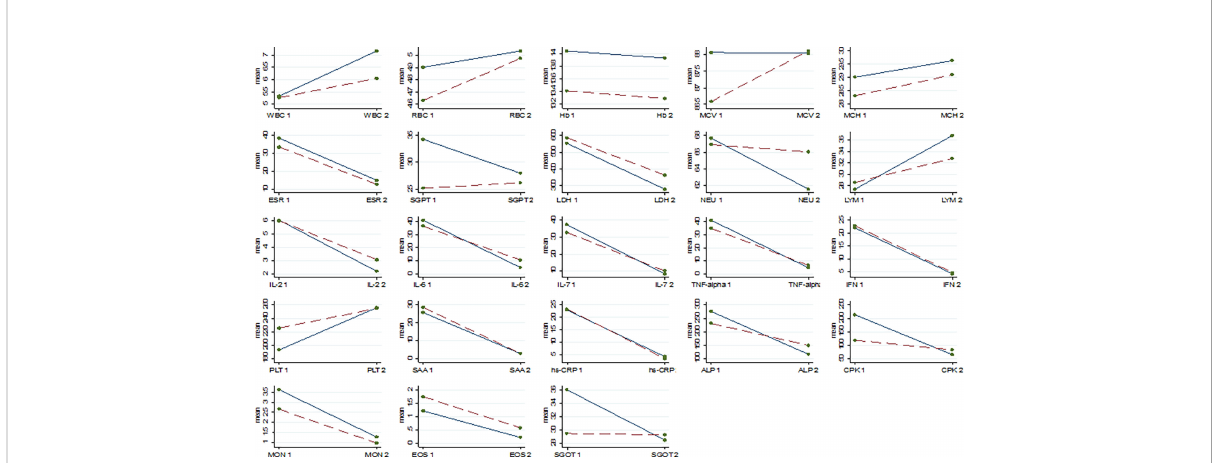
FIGURE 2 The change of mean of laboratory parameters from baseline (1) to end line (2); White Blood Cell (WBC), Red Blood Cell (RBC), Hemoglobin (HB), Mean Corpuscular Volume (MCV), Mean Corpuscular Hemoglobin (MCH), Erythrocyte Sedimentation Rate (ESR), Serum Glutamate-Pyruvate Transaminase (SGPT), Lactate Dehydrogenase (LDH), Neutrophil (NEU), Lymphocyte (LYM), Interleukin-2 (IL-2), Interleukin 6 (IL-6), Interleukin 7 (IL-7), Tumor Necrosis Factor (TNF)-alpha, Interferon (IFN), Platelet (PLT), Serum Amyloid A (SAA), High-Sensitivity C-Reactive Protein (hs-CRP), Serum Glutamic-Oxaloacetic Transaminase (SGOT), Alkaline Phosphatase (ALP), Creatine Phosphokinase (CPK), Monocytes (MON), Eosinophil (EOS); the change for Standard + NBS treatment group is solid line, the change for Standard treatment only group is Dash